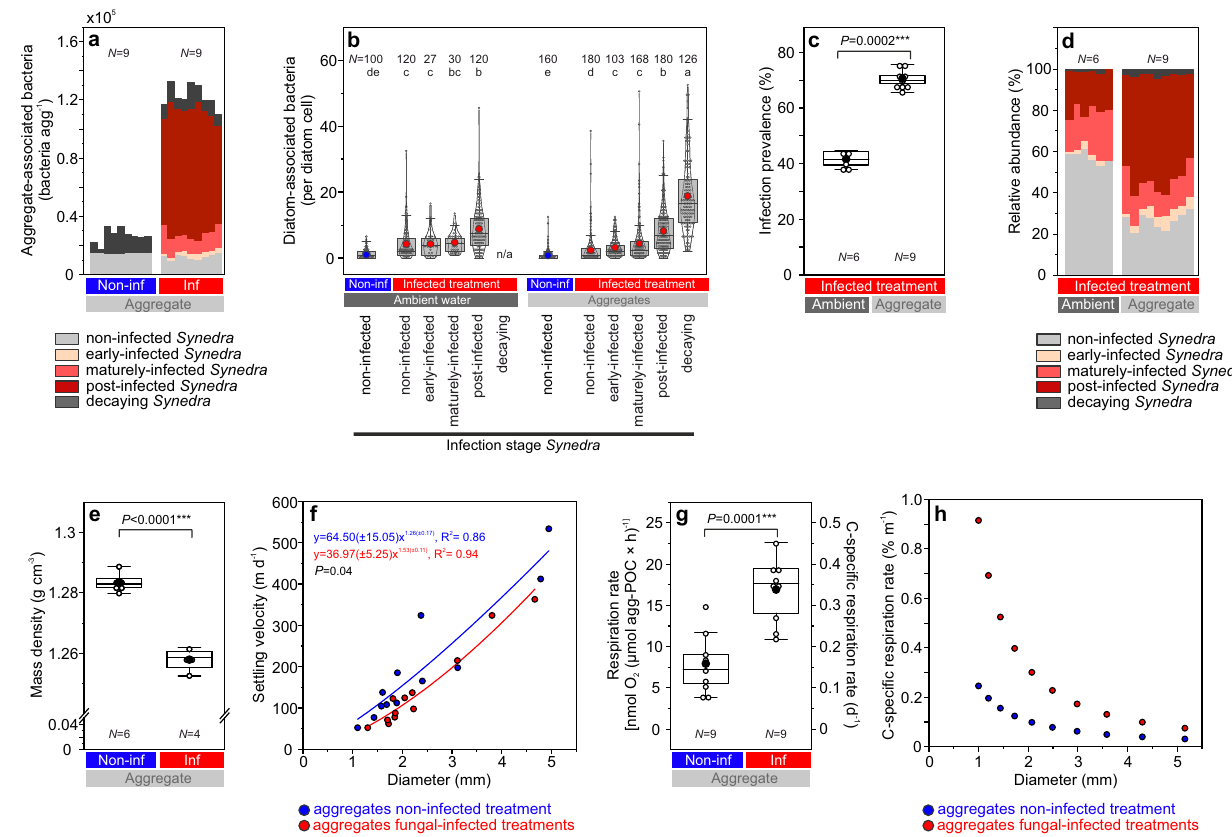
Fig. 5 Bio-physical properties of single aggregates formed from non-infected and fungal-infected diatom cultures in rotating cylinders. Bacterial abundances on whole aggregates ( a ) and single Synedra cells ( b ), infection prevalence ( c ), and relative abundances of different Synedra cell types within aggregates and in the ambient water ( d ). Bacteria in a were grouped based on their association with individual Synedra cell types within single aggregates. The letters a – e in b denote signi fi cantly different groups (Kruskal – Wallis, P < 0.05). N indicates the number of analyzed cells. Data in b are shown as single data points (white circles), the 25th, 50th, and 75th percentile (grey boxes), mean values (blue and red- fi lled circles), and distribution curves (kernel smoothing). Stacked bars in a , d represent individual replicates. Mass density ( e ), settling velocities ( f ), and respiration rates ( g , h ) of single aggregates. f Settling velocities were positively correlated with the aggregate diameter. Fitted curves (power function) were signi fi cantly different between both treatments ( P = 0.04). Blue and red items represent data from the non-infected and fungal-infected aggregates, respectively. g Respiration rates given